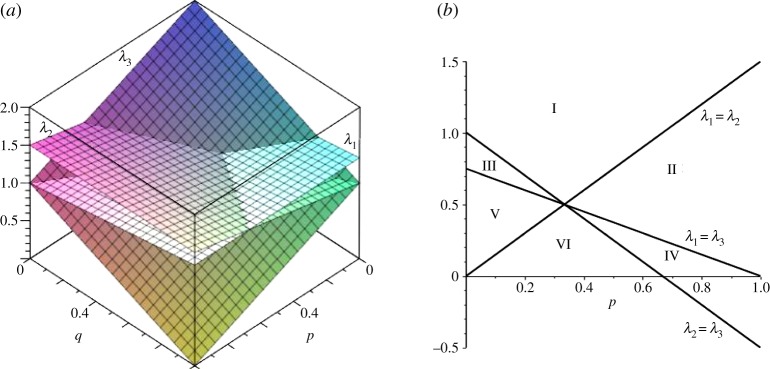
(a) Eigenvalues of Δ for (3,4) partial bipartite graph as functions of (p,q). λ1=(3+q)/3,λ2=(2+p)/2,λ3=2−p−q. (b) Equal value lines for eigenvalues of Δ for (3,4) partial bipartite graph.